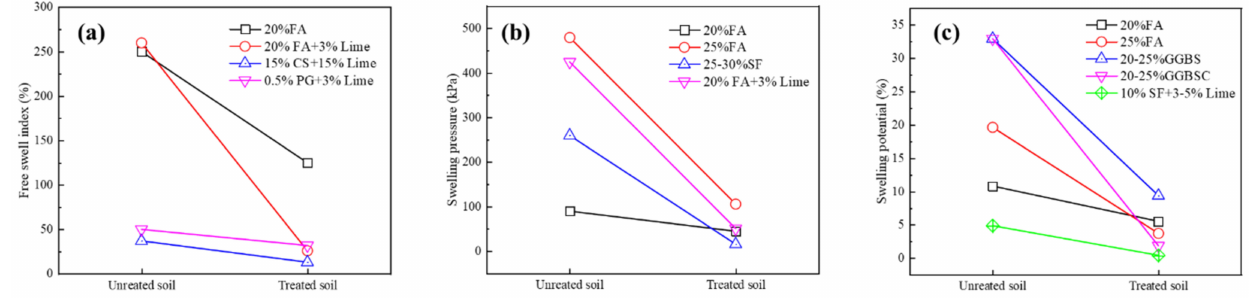
Figure 10. Influence of industrial solid waste on swelling and shrinkage of expansive soil: ( a ) free swell index; ( b ) swelling pressure; ( c ) swelling